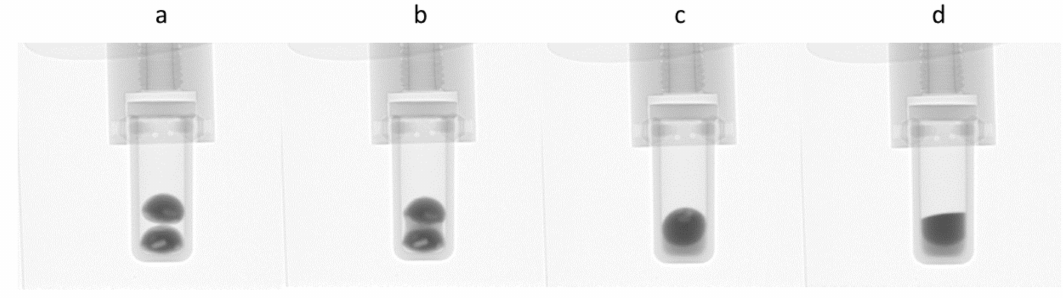
Figure 7. Melting and liquid phase separation of stacked CoCrCu samples. ( a ) During initial heating, the two as-cast buttons are intact. ( b ) The Cu-rich phase melts first between 1075 and 1100 ◦ C, and ( c ) pools at the bottom of the crucible. ( d ) The Cu-lean phase fully melts upon heating to 1500 ◦ C. Full video available in the